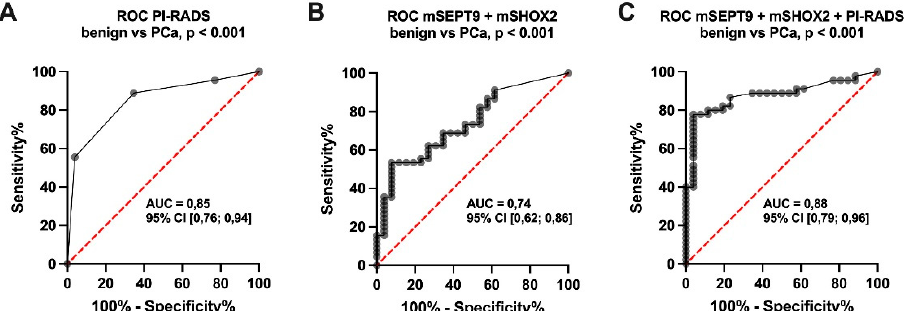
Figure 4. ROC curve analysis of PI-RADS vs. mSHOX2 / mSEPT9 one hour after biopsy and the composite score of mSHOX2 / mSEPT9 /PI-RADS comparing healthy and primary PCa at prostate biopsy. The ROC curve analysis of PI-RADS ( A ) vs. mSHOX2 / mSEPT9 ( B ) one hour after biopsy and the composite score of mSHOX2 / mSEPT9 /PI-RADS ( C ) comparing healthy and primary PCa at prostate biopsy is represented.